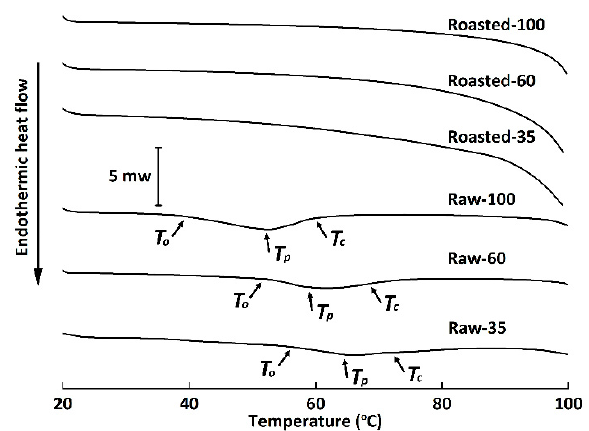
Figure 4. Differential scanning calorimetry thermograms of raw and sand-roasted highland barley flours. Raw-35, Raw-60, and Raw-100 indicate raw highland barley flour as coarse (250–500 µ m), medium (150–250 µ m), and fine (<150 µ m) fraction, respectively; while Roasted-35, Roasted-60, and Roasted-100 indicate sand-roasted highland barley flour as coarse (250–500 µ m), medium (150–250 µ m), and fine (<150 µ m) fraction, respectively. To , onset temperature; Tp , peak temperature; Tc , conclusion temperature.